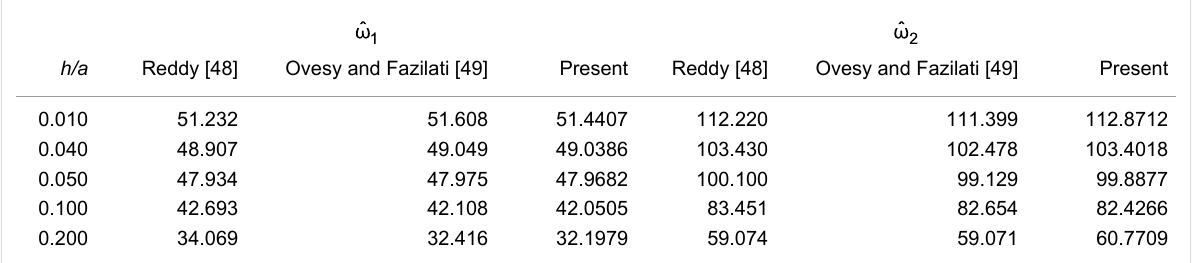
Table 7: Fundamental and second symmetric mode frequency parameters,